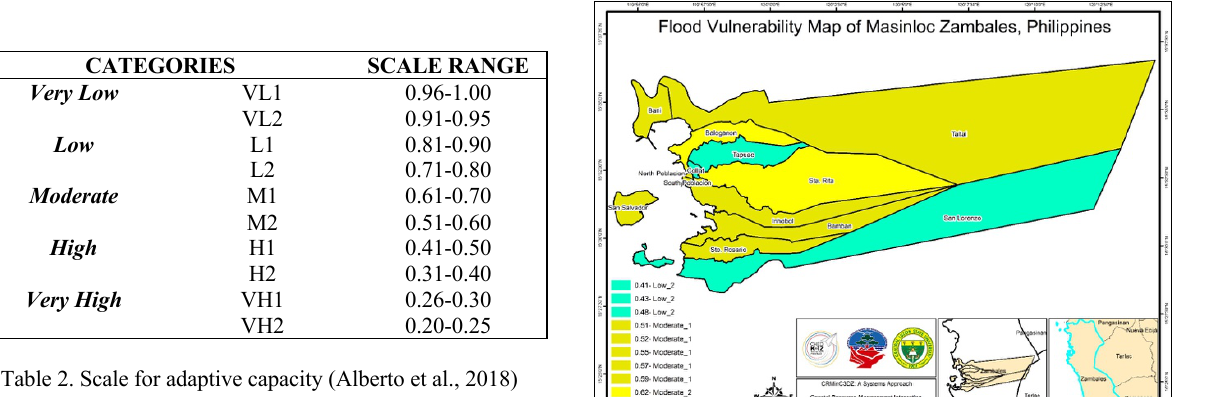
Table 2. Scale for adaptive capacity (Alberto et al., 2018)